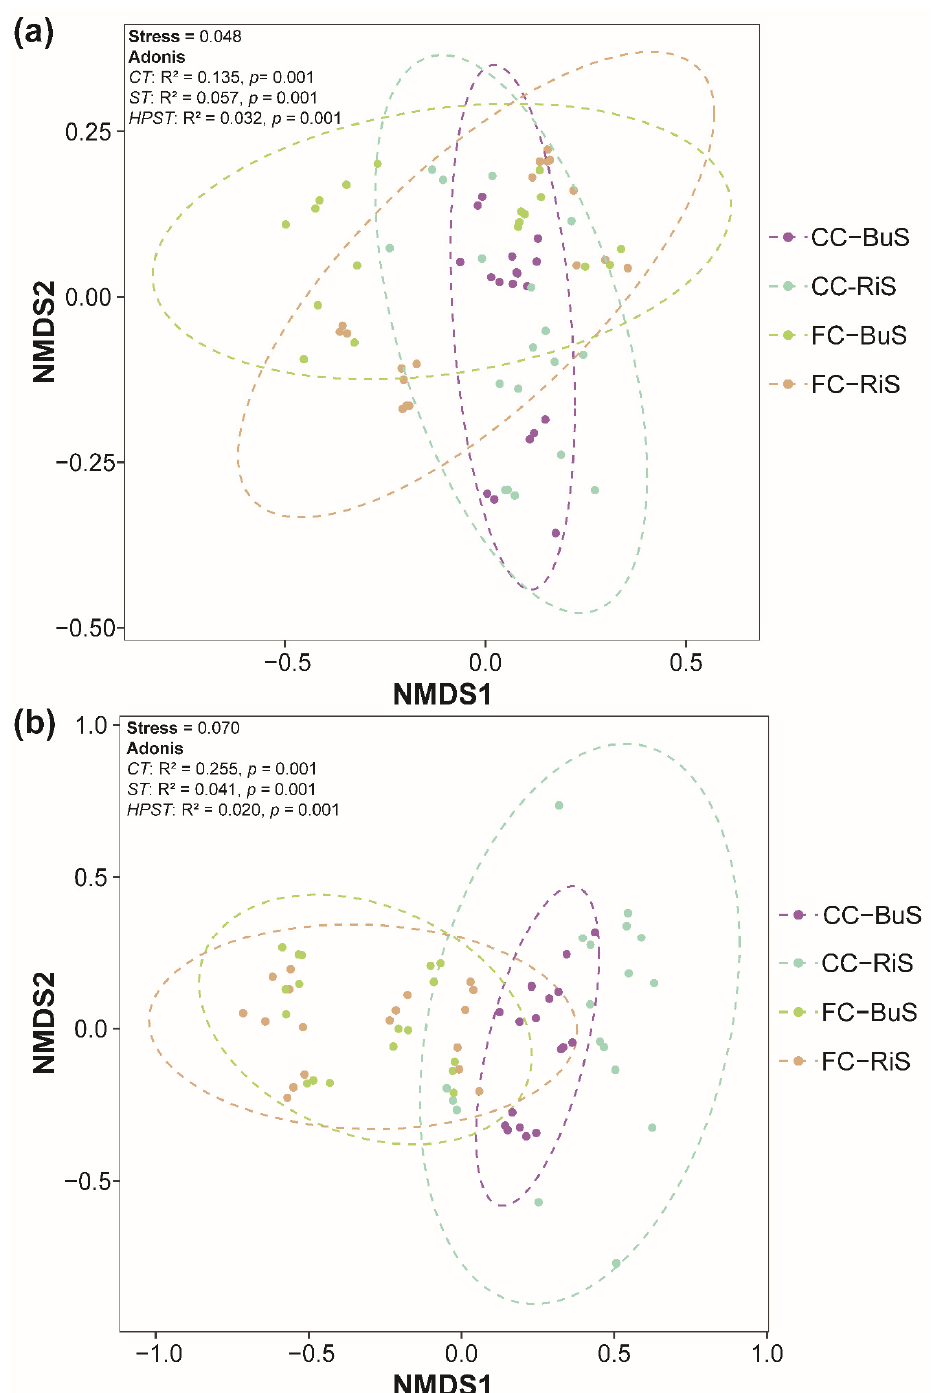
Figure 4. NMDS plots indicating the beta-diversity for ( a ) soil bacteria and ( b ) fungi. Different crop types along with the soil fraction have been designated with different colors. “CC − BuS”: Chinese cabbage and bulk soil, “CC − RiS”: Chinese cabbage and rhizospheric soil, “FC − BuS”: flower cabbage and bulk soil, “FC − RiS”: flower cabbage and rhizospheric soil. Stress values, p -values and ANOSIM and Adonis test confirmatory values are indicated on the top of each